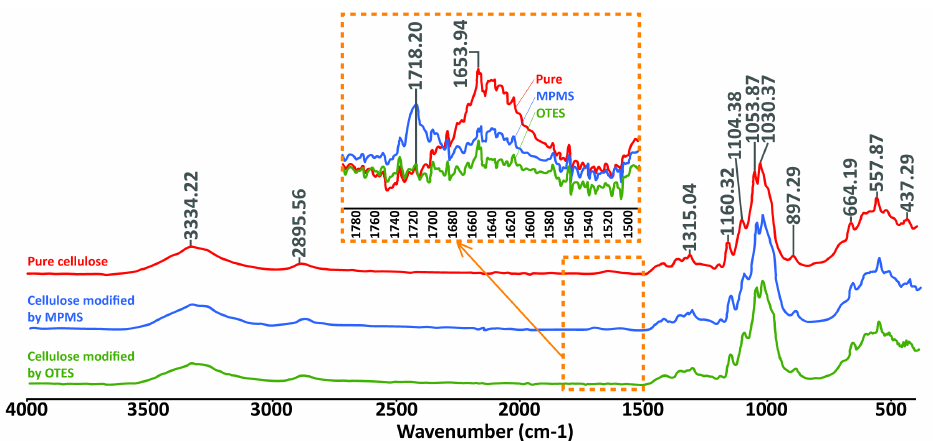
Figure 3. FTIR spectra of cellulose before and after the modification with silanes.